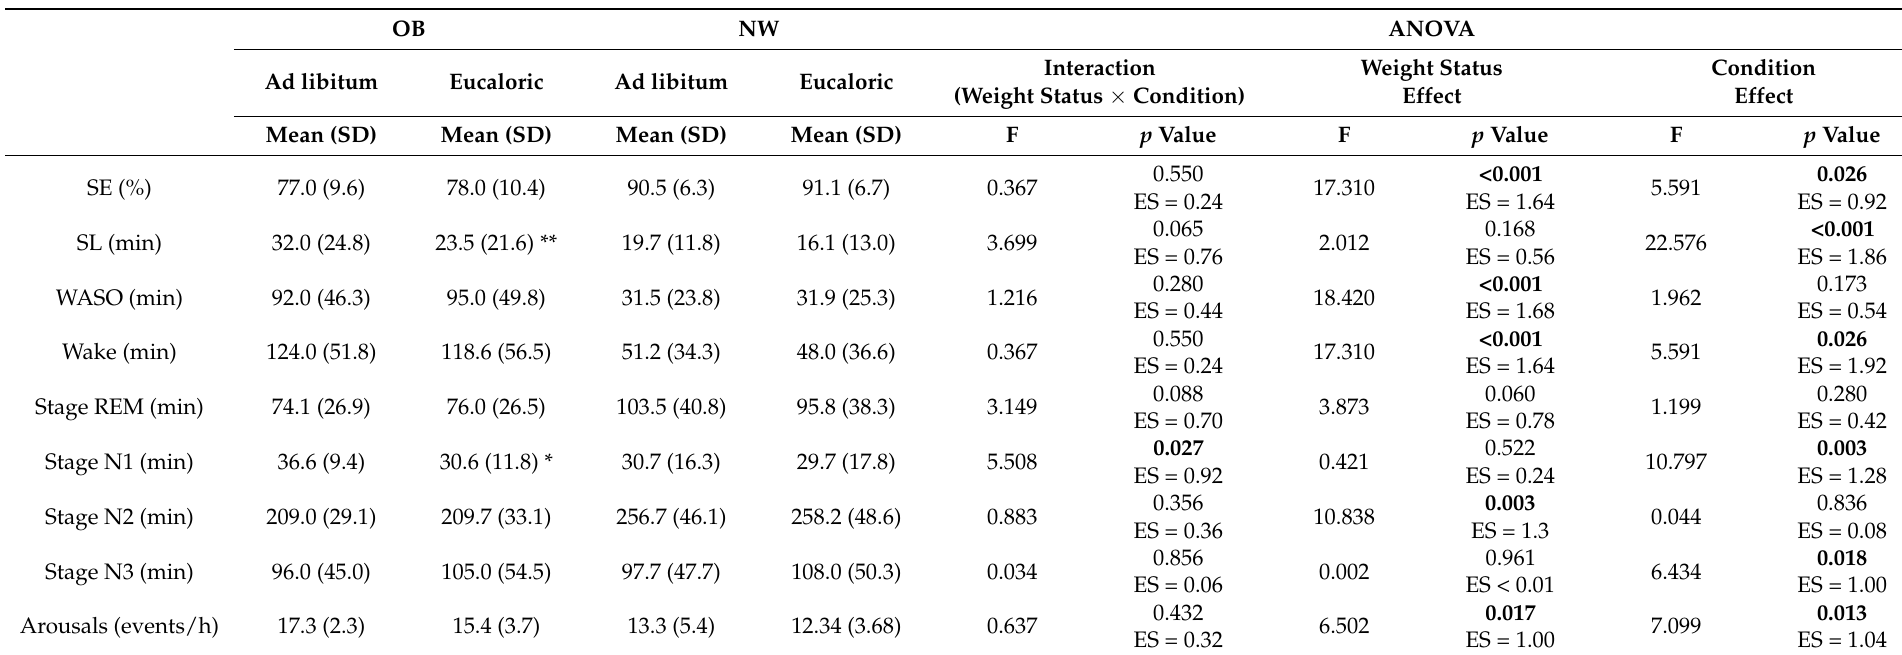
Interaction Weight Status Condition (Weight Status × Condition) Effect Effect